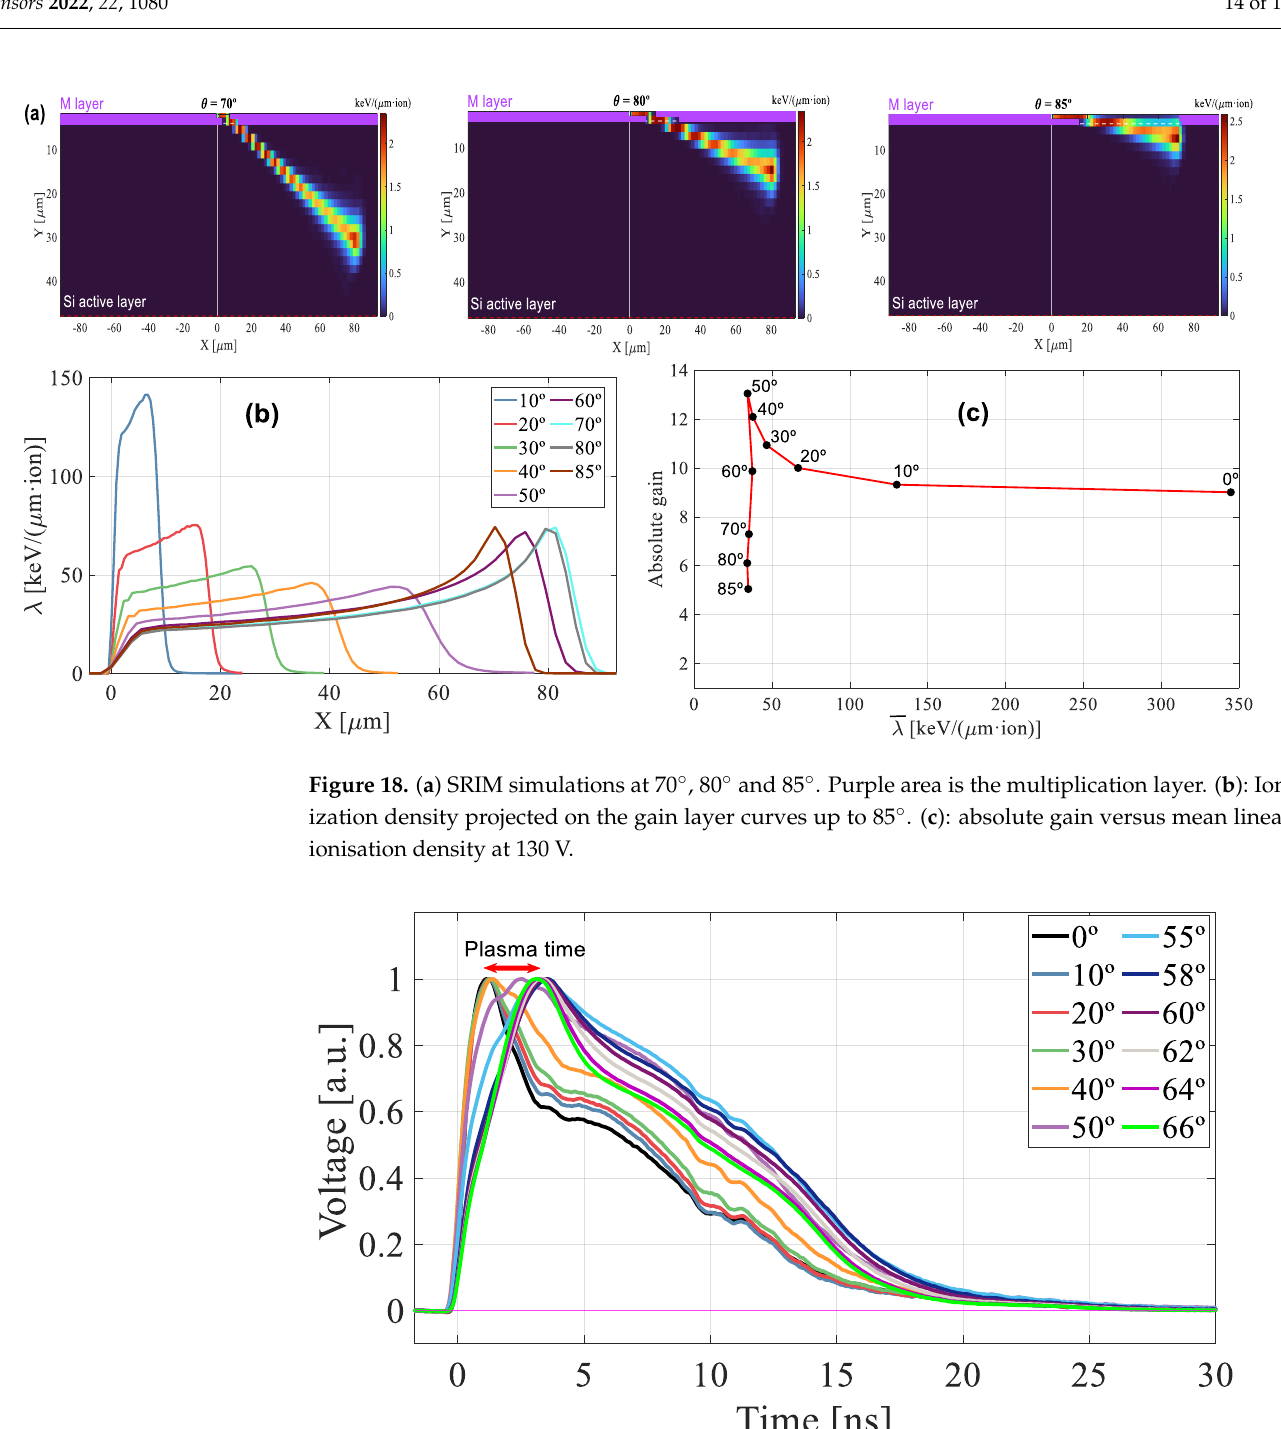
Figure 17. Absolute gain curves for angles from 0° to 85°.